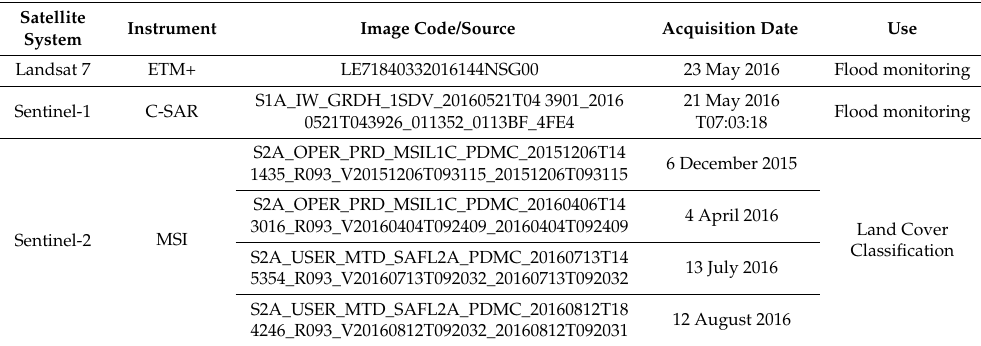
Table 1. Satellite images data